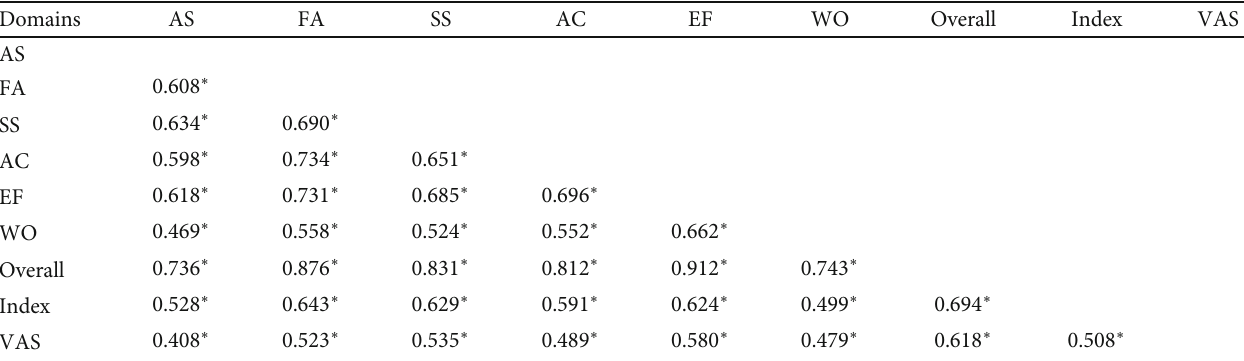
Table 3: Spearman ’ s correlation coe ffi cients between CLDQ and EQ-5D